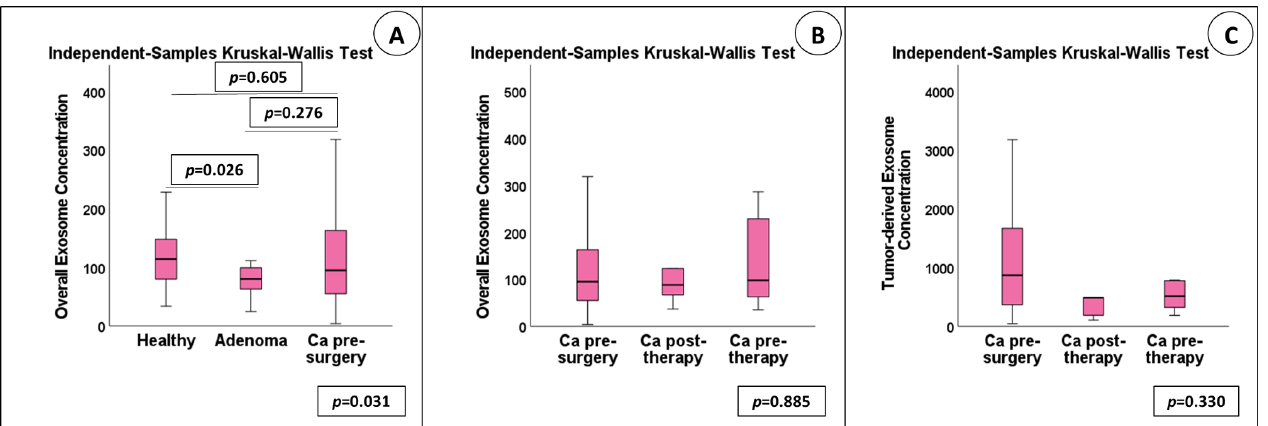
Figure 6. Overall plasma sEVs concentration in healthy controls (n = 39), patients with adenomas (n = 39) and patients with CRC (n = 65) ( A ), overall plasma sEVs concentration in patients with CRC before surgery (n = 65), before (n = 7) and post systematic treatment (n = 5) ( B ) and tumor ‐ derived plasma sEVs concentration in patients with CRC before surgery (n = 65), before (n = 7) and post systematic treatment (n = 5) ( C ).